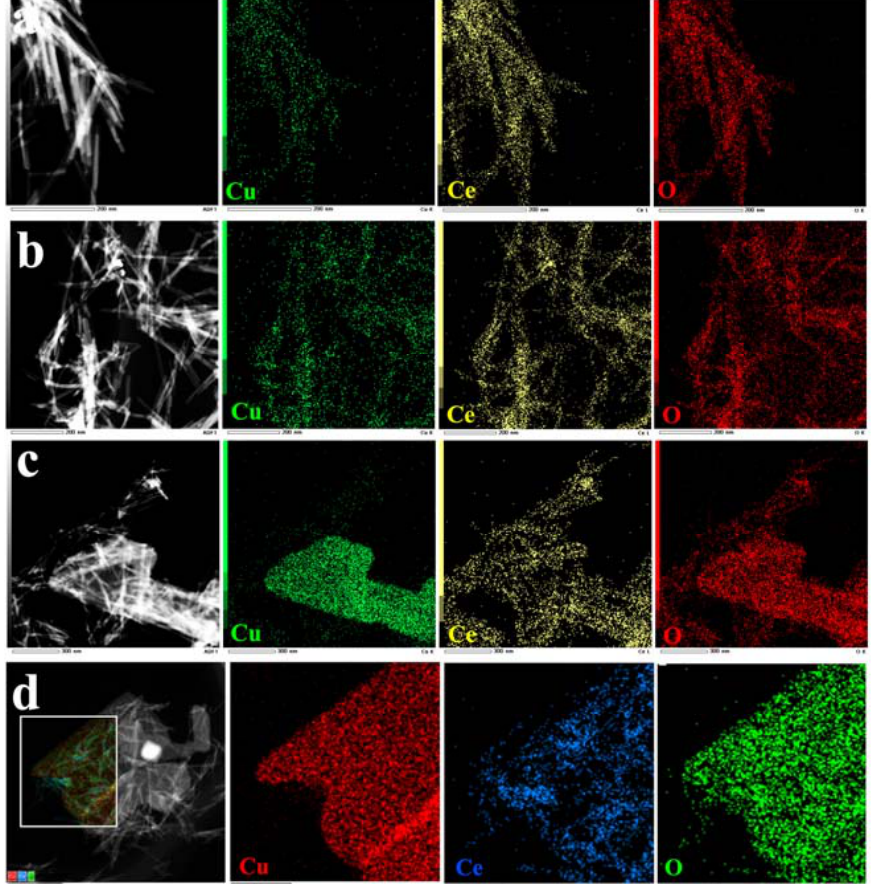
Figure 4. EDX maps of various elements in the CuO/CeO 2 catalysts: ( a ) 10%Cu/Ce, ( b ) 20%Cu/Ce, ( c ) 50%Cu/Ce, and ( d ) 80%Cu/Ce. ( c ) 50%Cu/Ce, and ( d )